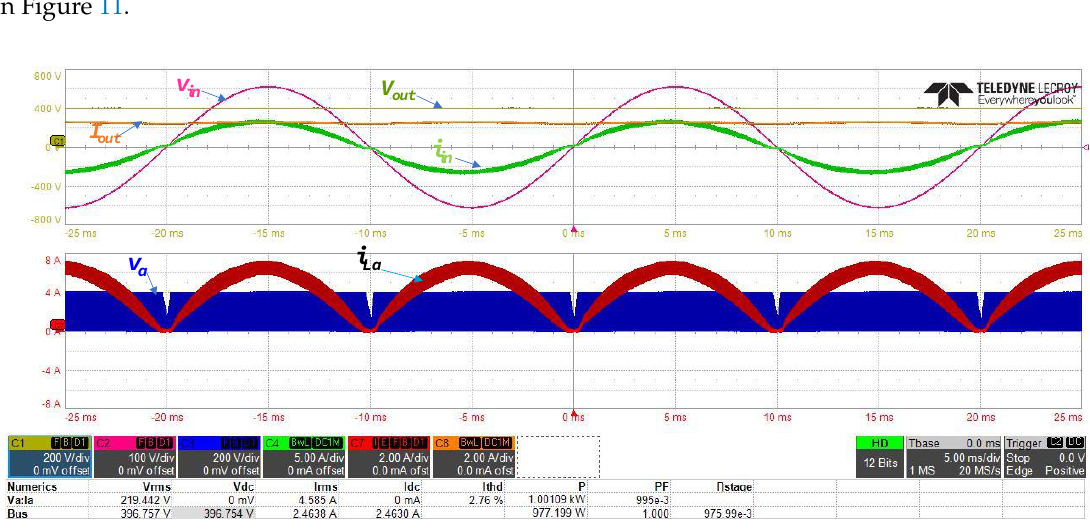
Table 3. Main IBPFC Electrical quantities at a different input power.